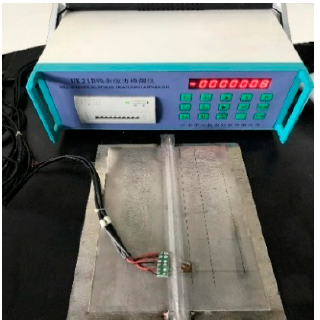
Figure 5. Stress measurement by blind hole method.